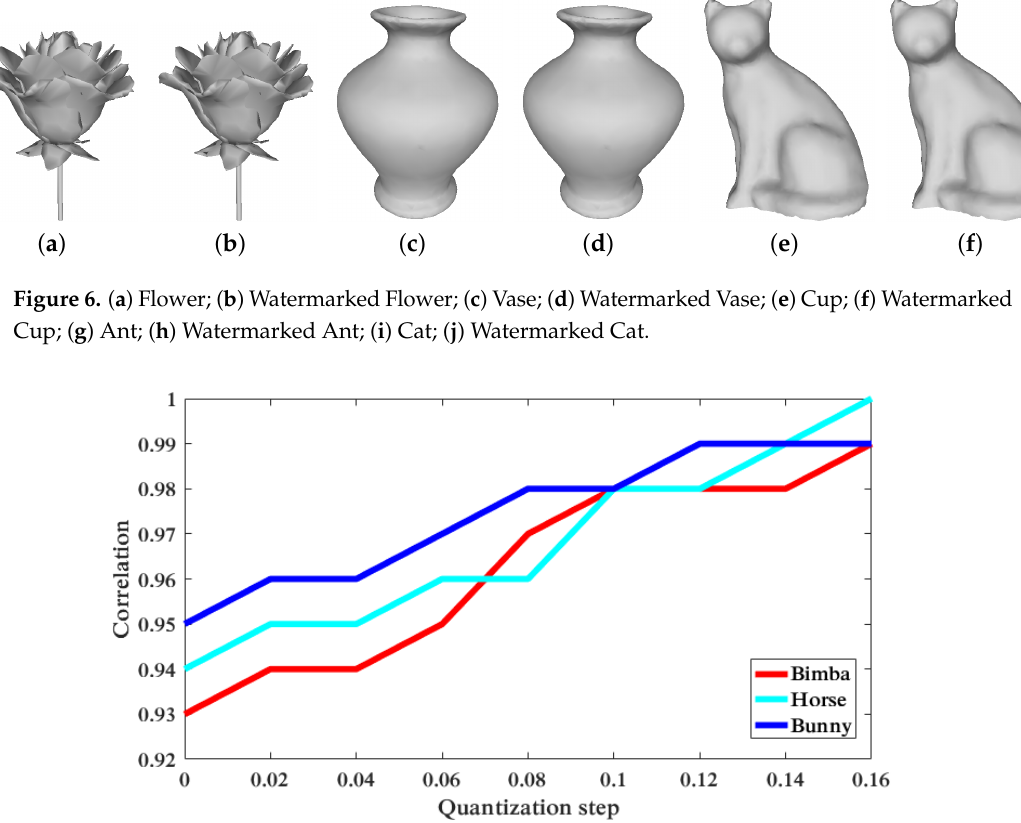
Figure 7. The robustness performance in terms of correlation using several quantization steps for Bimba, Horse, and Bunny models.